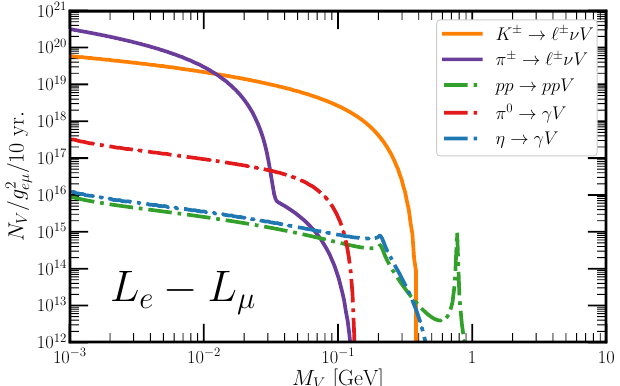
Figure 9 . The number of L e L (cid:22) gauge bosons V traveling towards the DUNE MPD as a function (cid:0) of mass M V assuming ten years of data collection, and equal run time in neutrino and antineutrino modes. Solid lines display expected number due to charged meson decays | purple ( (cid:25) (cid:6) ) and orange ( K (cid:6) ). Dot-dashed lines display expected number due to processes relying on kinetic mixing | red ( (cid:25) 0 decay), blue ( (cid:17) decay), and green ( pp ppV !